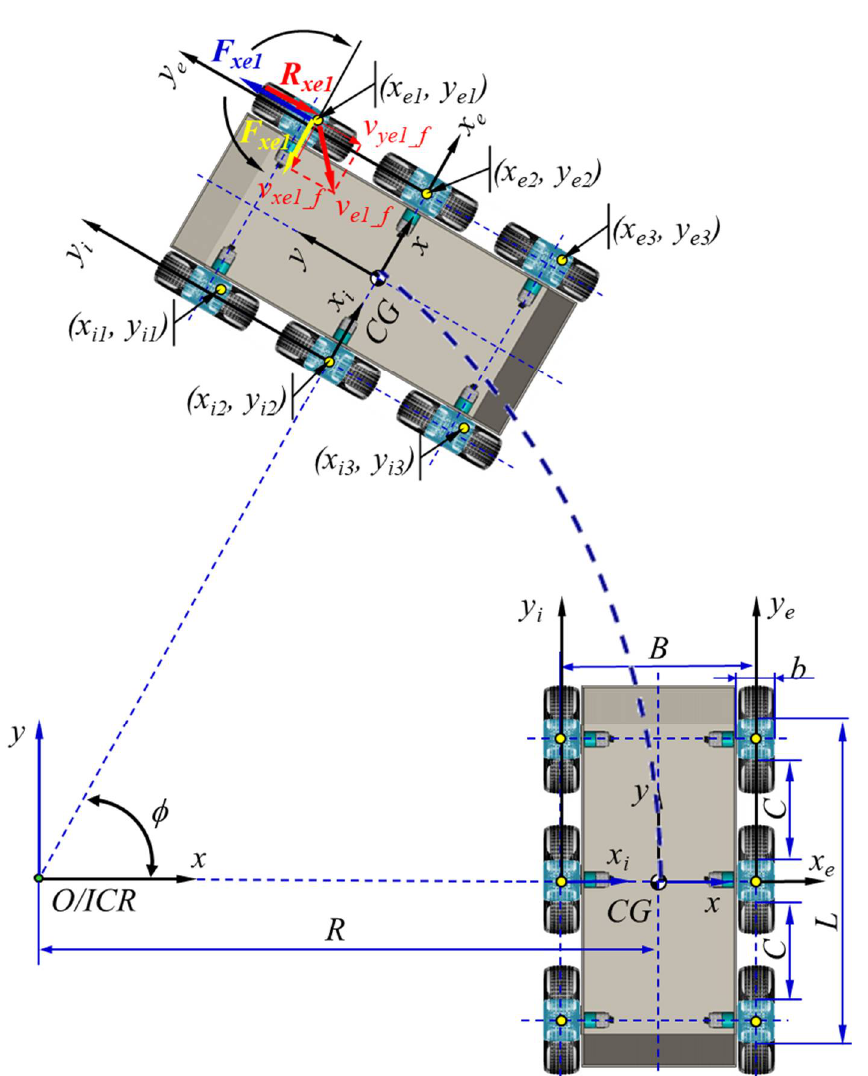
Figure 6. Schematic of the 2D dynamics of the 6 × 6 robot, which had some specificities related to the choice of travel mode. The ground contact spots of the six wheels were identical. Working conditions are ideal when Md = Mr (Md—motor torque; Mr—resistant moment). The geometric center of the contact spots (yellow dots) during the turn is represented outside the geometric center of the contact spots. This representation suggests that progression in the field is influenced by different coefficients and that each operational platform can create an additional balance.